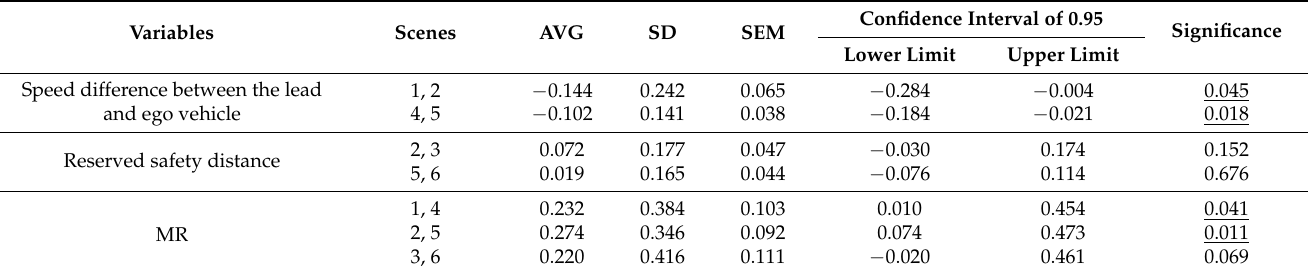
Table 6. T -test results of the influence of variables on pupil